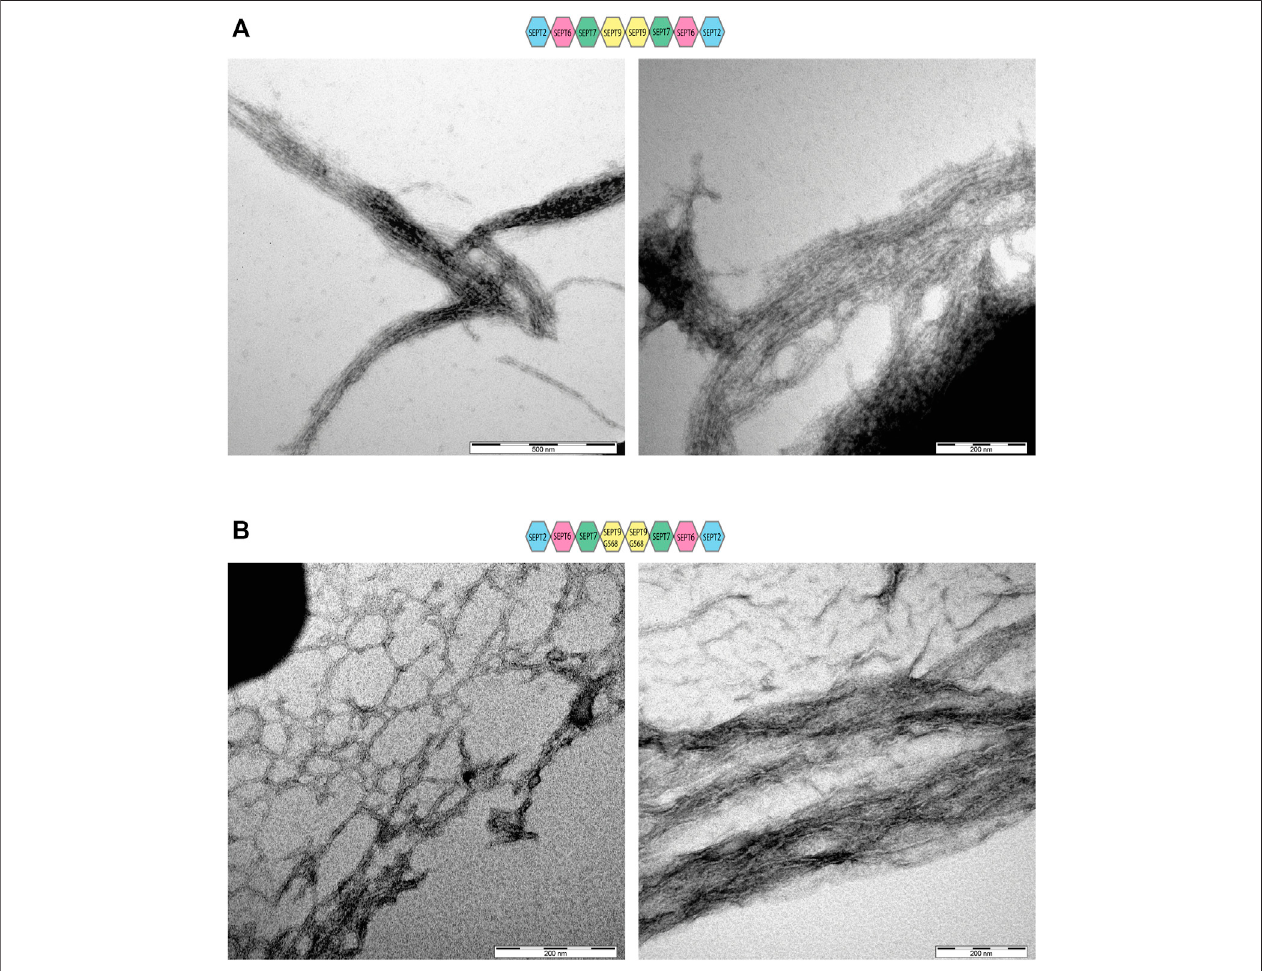
FIGURE 2 | Electron microscopy of SEPT9 FL and SEPT9 G568 containing septin rods. Negative stains of septin fi laments obtained by dialysis in low salt buffer showing bundles and network-like structures. (A) Electron microscopy of septin fi laments containing SEPT9 FL . (B) Electron microscopy of septin fi laments containing SEPT9 G568